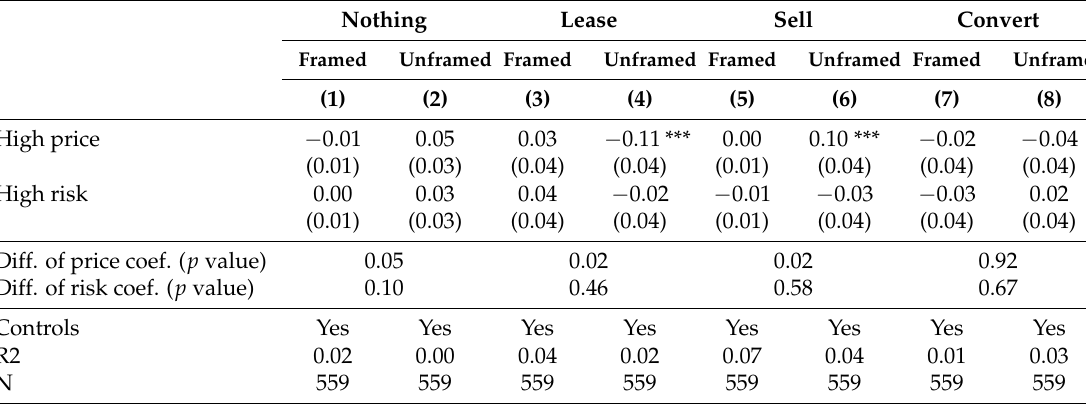
Table 4. The response of experimental choices to price and risk